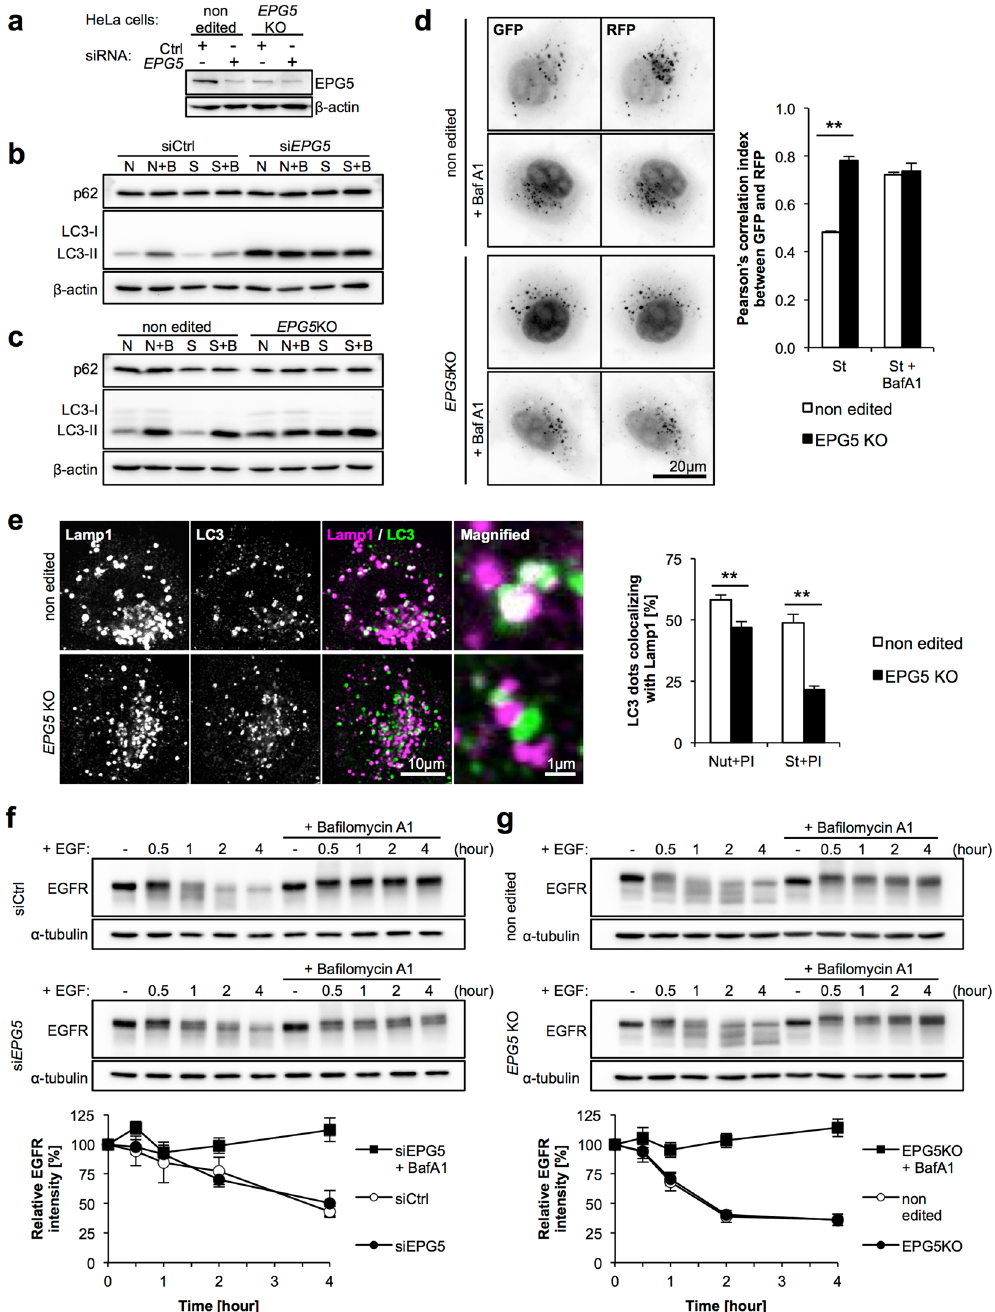
Figure 3. Autophagic impairment is caused by reduced fusion between autophagosomes and lysosomes in EPG5 KD and KO cells. ( a ) EPG5 depletion by siRNA treatment. ( b , c ) LC3-II has accumulated and autophagic flux is stopped in EPG5 KD and KO HeLa cells. ( d ) Tandem fluorescent-tagged LC3 (tf-LC3) assay indicated reduced autophagosome-lysosome fusion. EPG5 KO cells were infected with a retroviral mRFP-GFP-LC3 construct, then incubated in nutrient-rich or starved media with/without BafA1 for two hours. BafA1 inhibited lysosomal V-ATPase and led to disruption of the lysosomal acidic environment, as well as inhibition of autophagosome-lysosome fusion, which we used as the negative control for this experiment. RFP and GFP fluorescence images were obtained, and Pearson’s correlation index was calculated to show colocalization between RFP and GFP. Higher colocalization indicates accumulation of autophagosomes. ( e ) Colocalization of punctate LC3 staining with Lamp1 in the presence of protease inhibitors was lower in EPG5 KO cells under both nutrient rich and starved conditions. ( f , g ) Endocytic degradation of EGFR was normal in EPG5 KD and KO cells. N or Nut, nutrient-rich conditions; S or St, starved conditions; B or BafA1, Bafilomycin A1; PI, protease inhibitors (E64d + pepstatin A). The mean and SD are from at least three independent experiments, with 10 images assessed per treatment condition. Statistical analysis was performed using a two-tailed Student’s t -test; ** p <